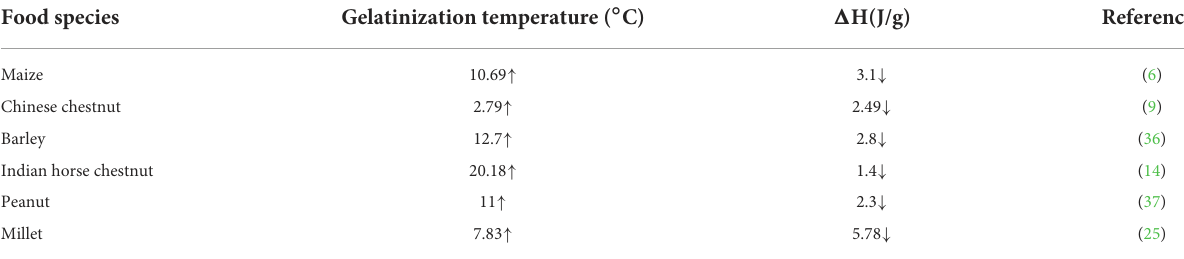
TABLE 3 Effect of microwave treatment on starch gelatinization parameters in food. Food